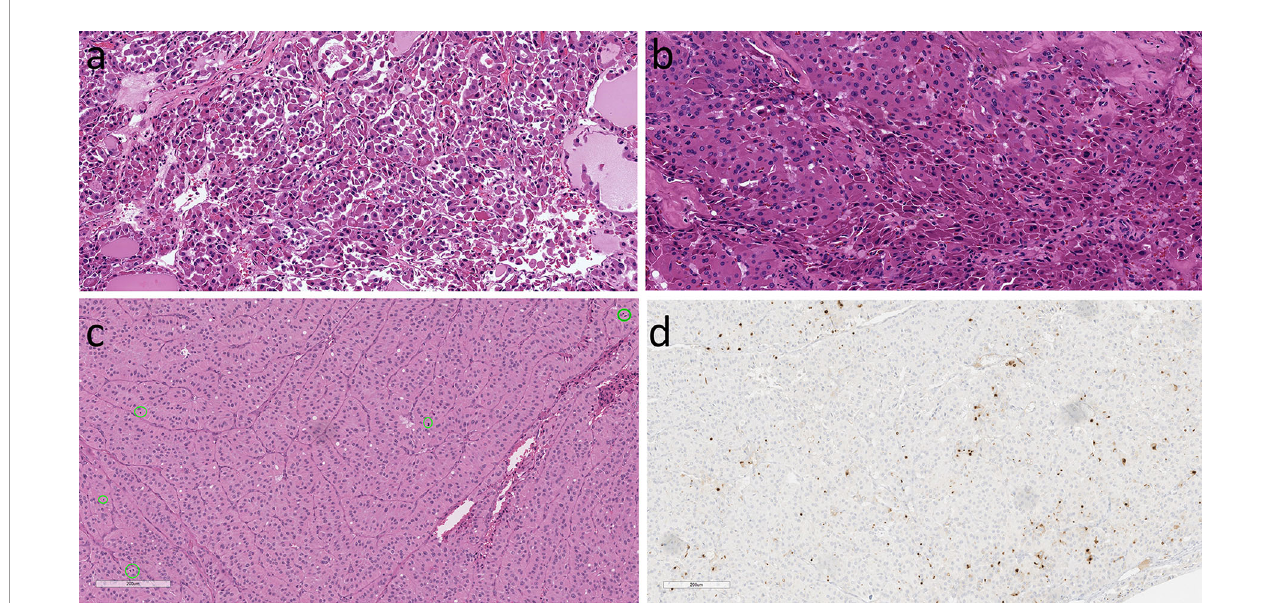
FIGURE 9 | Oncocytic Poorly Differentiated Thyroid Carcinoma. These aggressive tumors are characterized by discohesive solid growth (A) and focal tumor cell necrosis (B) with increased mitotic activity. that exceeds 3 per 2mm 2 (C) and loss of thyroglobulin expression (D)